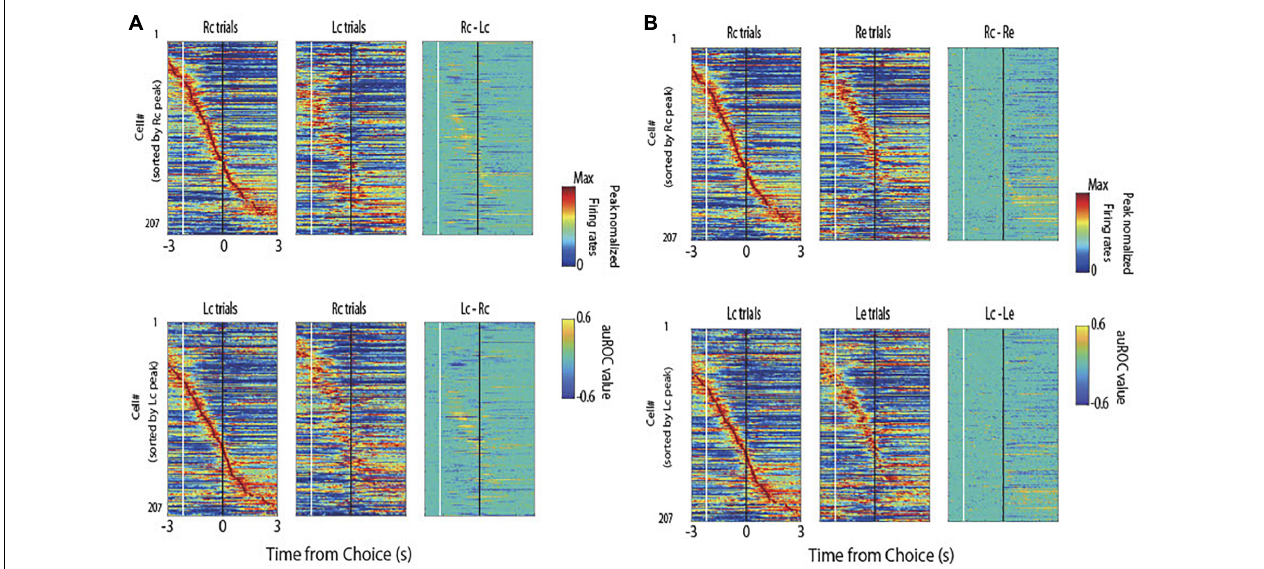
FIGURE 2 | Normalized peak firing rates and area under the receiver operating characteristic (auROC) values of all pyramidal neurons. (A) Firing patterns across all pyramidal neurons ( n = 207) for the right correct (Rc) and left correct (Lc) trials. In each trial type, the mean firing rate of each neuron was normalized to its peak (left and middle panels), and auROC values were calculated by comparing the firing rates of Rc trials to those of Lc trials (upper) and Lc trials to those of Rc trials (lower). These neurons were sorted by their peak firing time in Rc trials (upper) and Lc trials (lower). White and black lines indicate the times of tone stimulus on and choice response, respectively. The right panels represent the firing rates subtracting Lc trials from Rc trials (upper) and Rc trials from Lc trials (lower). (B) Firing patterns across the same neurons for the Rc and right erroneous (Re) trials (upper) and Lc and Le trials (lower) are shown as in panel (A) .